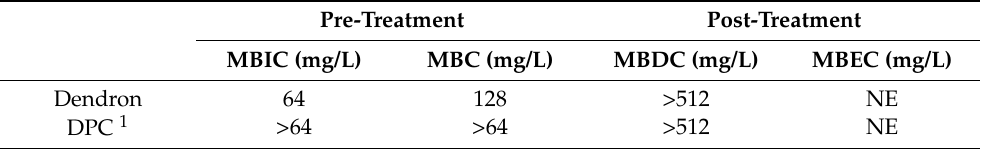
Table 1. MBIC, MBC, MBDC and MBEC values of dendron and DCP against S. aureus biofilm formation (pre-treatment) and established biofilms (post-treatment).